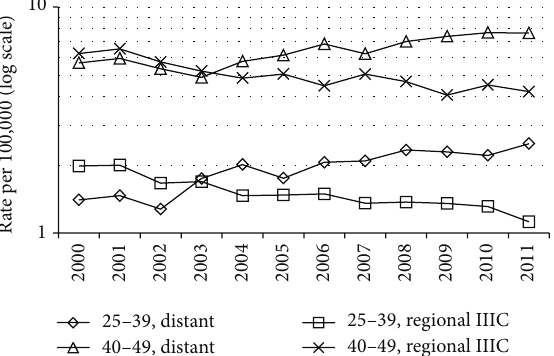
Figure 2: Age-standardized incidence rate for breast cancer diag- nosed at ages 25–39 years and 40–49 years in 2000–2011: distant summary stage versus SEER breast-adjusted AJCC 6th stage IIIC within regional summary